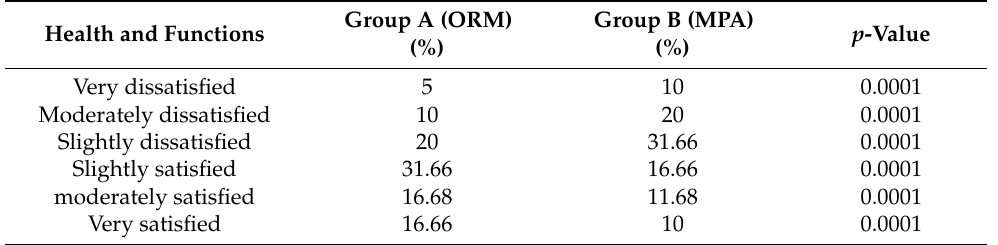
Table 5. Comparison of ORM and MPA Group on level of health and functioning subscale among the patients with abnormal uterine bleeding after